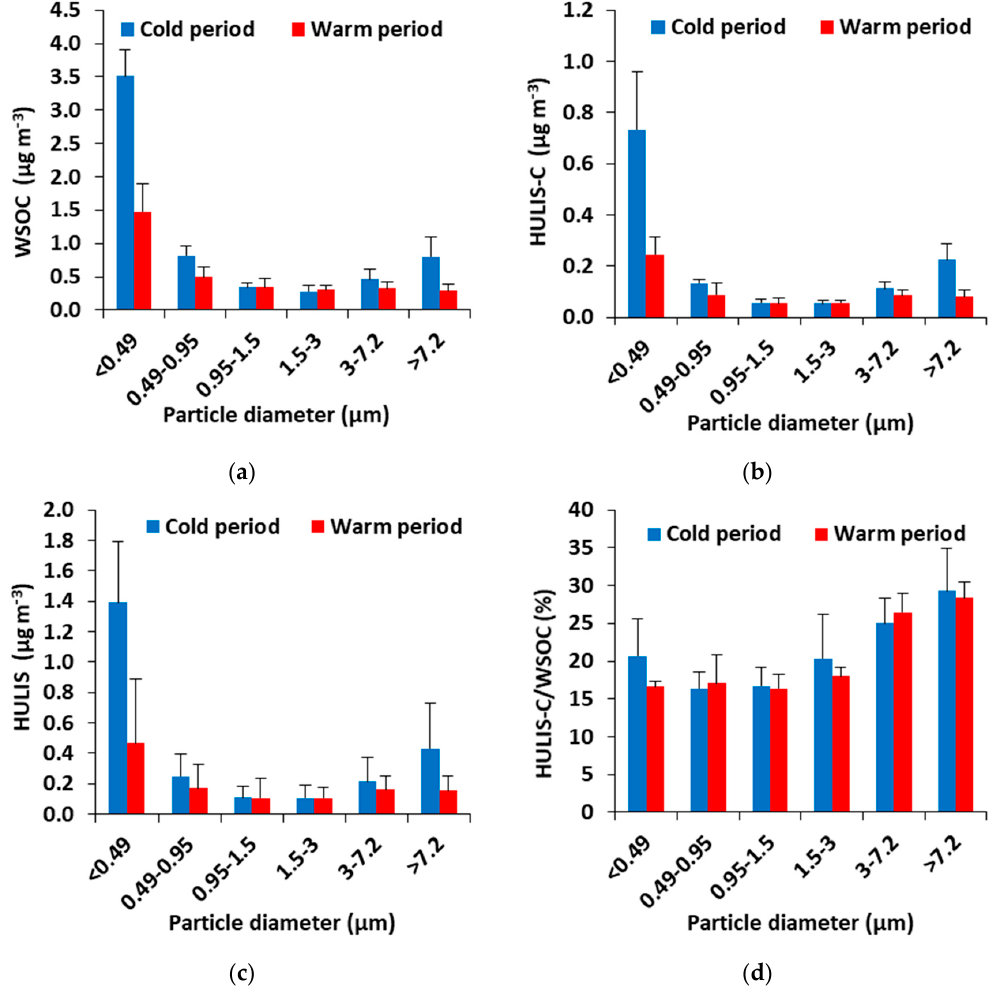
Figure 1. Average concentrations of: ( a ) WSOC; ( b ) HULIS-C; ( c ) HULIS; ( d ) HULIS-C/WSOC ratio; in various size fractions during cold and warm periods (Error bars show min and max).